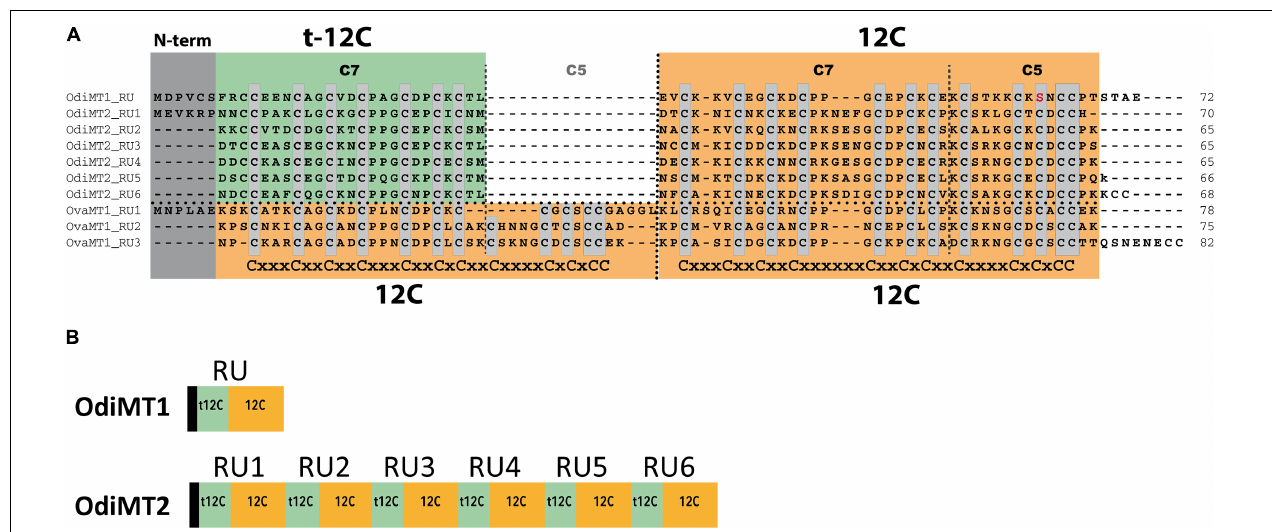
FIGURE 1 | Domain organization of O. dioica metallothioneins. (A) Amino acid alignment of O. dioica OdiMT1 and OdiMT2 split in its repeat units (RU1–RU6). The sequence of O. vanhoeffeni MT (OvaMT1) split in its repeat units (RU1–RU3) has been included to show that the amino-terminal 12C domains of OdiMT1 and of the RU of OdiMT2 are “trimmed” (t-12C; green background), and lacks the C5 subunit. Conserved cysteines are highlighted in gray. The arrangement of Cys motifs of each 12C domain is showed below the alignment. Notice that the 12C domain (orange background) corresponds to previously described C7 + C5 subunits (Calatayud et al., 2018). (B) Schematic representation of the modular organization of OdiMT1 and OdiMT2 proteins. OdiMT1 consists of 6 amino acids of the N-terminus (black box) followed by a single repeat unit (RU) with a t-12C domain (green box) and a 12C domain (orange box), while OdiMT2 is made of six RU,